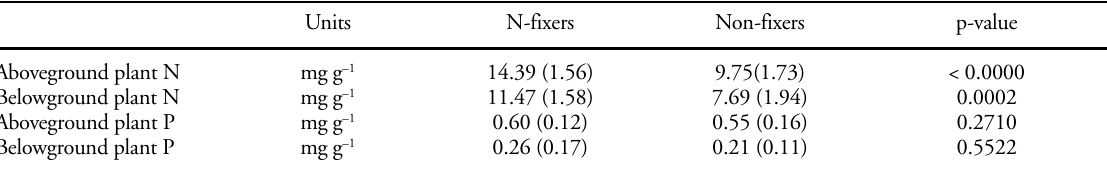
Table 3. Means and standard deviations of N and P concentrations of above- and belowground tissues of N-fixer (n = 20) and non-fixer (n = 10) scrubs in a heathland in northwest